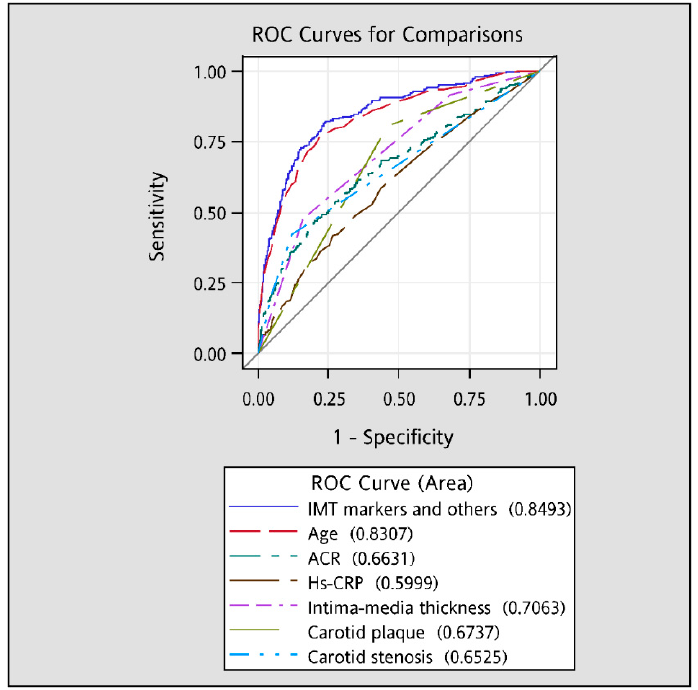
Figure 5. The areas under the receiver operating characteristic (AUROC) curves for all-cause mortality.